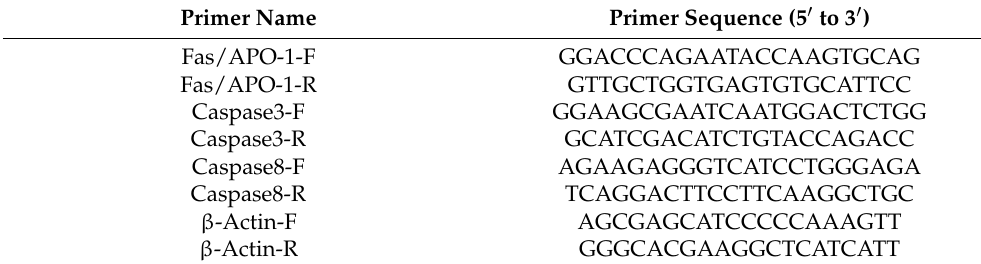
Table 2. Primer sequences were used in this